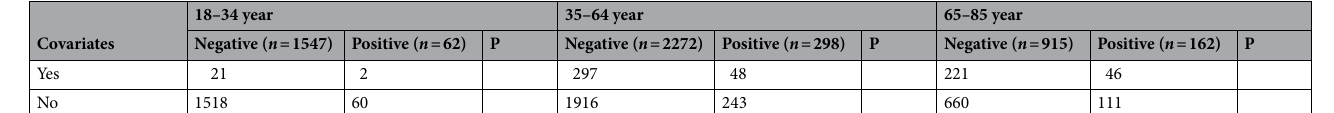
Table 1. The baseline characteristics of qualitative variables stratified by age and QFT-GIT results. BMI (Body Mass Index): defined according to CDC guidelines, TST (Tuberculin Skin Test): induration size as positive (≥ 10 mm) and negative (< 10 mm). Lived in household TB sick person: participant’s response to “Have you ever lived in the same household with someone while that person was sick with tuberculosis or TB?”. History of TB exposure: participant’s response to “Were you ever told that you had active tuberculosis or TB?”. TB medicine: participant’s response to “After getting a positive TB test, were you prescribed any medicine to keep you from getting sick with TB?”. Arthritis classification: participant’s response to “Has a doctor or other health professional ever told you had arthritis?” and “Which type of arthritis was it?”. Smoking status: current, having smoked 100 cigarettes and currently smoke every day or some day; former, having smoking 100 cigarettes but did not currently smoke; never, had not smoked 100 cigarettes. Alcohol use: participant’s response to “Have you had at least 12 drinks of any type of alcoholic beverage?”. Diabetes: participant’s response to “Other than during pregnancy, have you ever been told by a doctor or health professional that you have diabetes or sugar diabetes”.